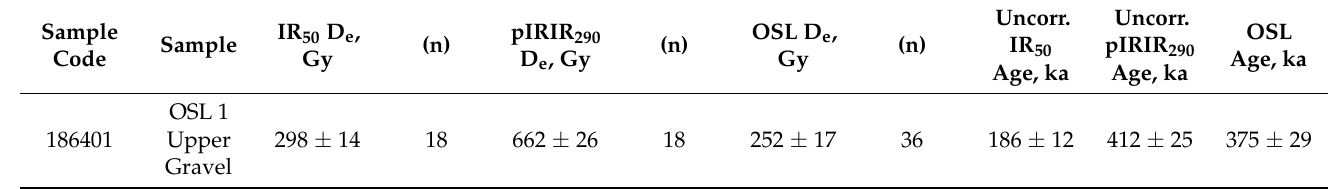
Table 3. Equivalent doses and luminescence ages. (‘n’ is the number of